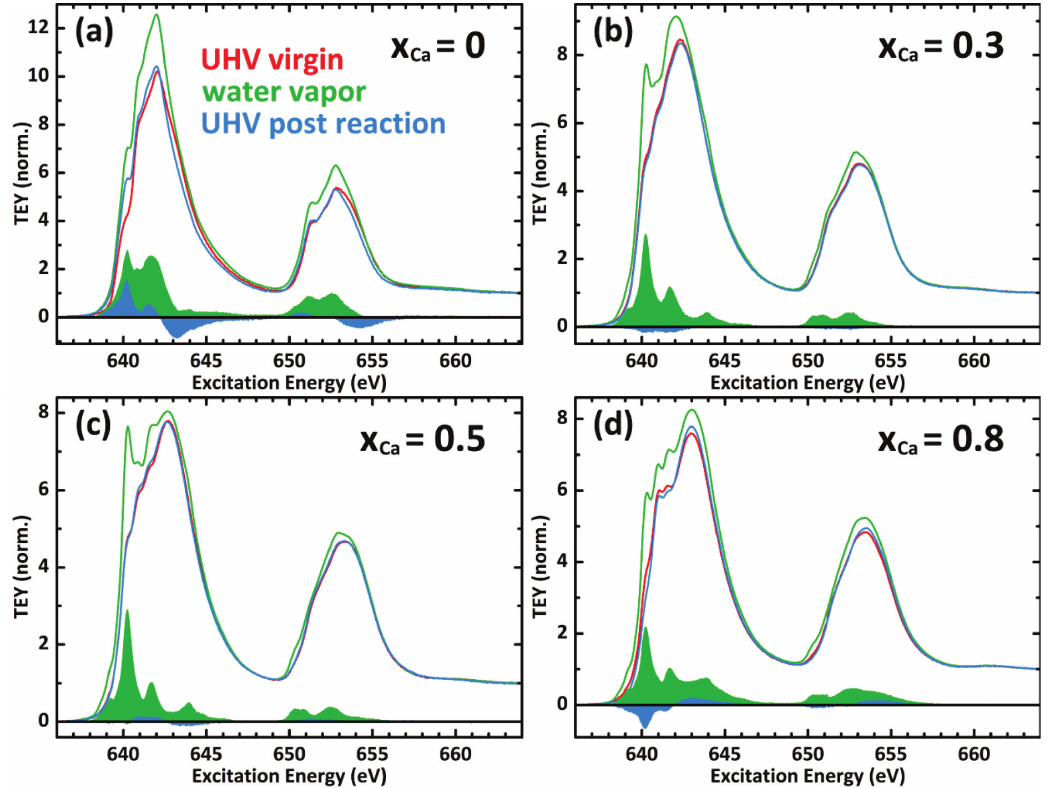
Figure 2. Normalized Mn L-edge spectra (Total Electron Yield) before (red) and during insertion of 0.1 mbar H O with sample bias of +2.5 V against chamber ground (green), as 2 well as in UHV after reoxidation in 0.1 mbar O (blue). Samples with x = 0 ( a ), x = 0.3 2 Ca Ca ( b ), x = 0.5 ( c ), and x = 0.8 ( d ). Filled curves represent the change from virgin to Ca Ca activated (green) and from virgin to post reaction